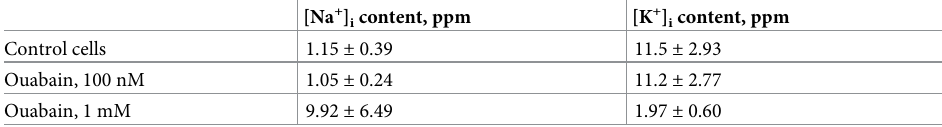
Table 1. Effect of ouabain on intracellular Na + and K + content in rat cerebellum granule cells. [Na + ] i content, ppm [K + ] i content, ppm Control cells 1.15 ± 0.39 11.5 ± 2.93 Ouabain, 100 nM 1.05 ± 0.24 11.2 ± 2.77 Ouabain, 1 mM 9.92 ± 6.49 1.97 ± 0.60 The cells were incubated in the absence or presence of 100 nM or 1 mM ouabain for 3 h. Intracellular Na + and K + content in the absence of ouabain was taken as 100%. Mean ± SD obtained in 3 independent experiments.